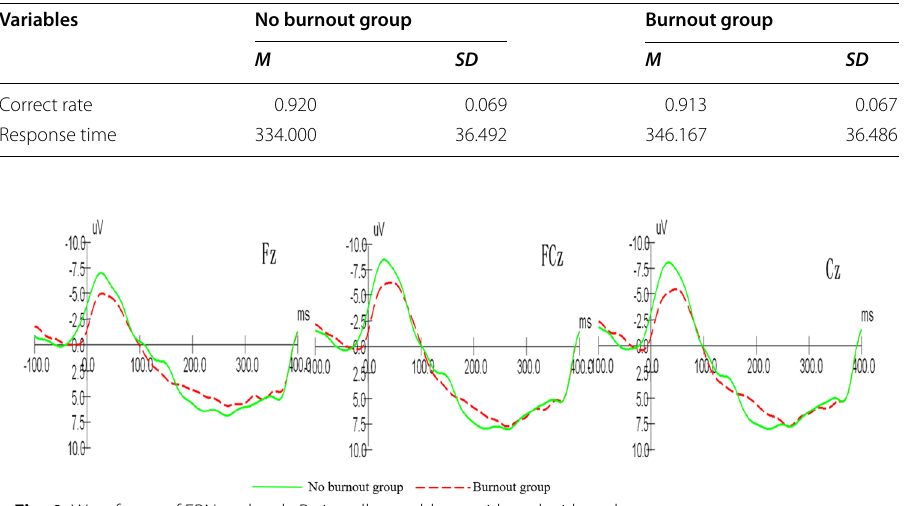
Fig. 4 Waveforms of ERN and early Pe in college athletes with and without